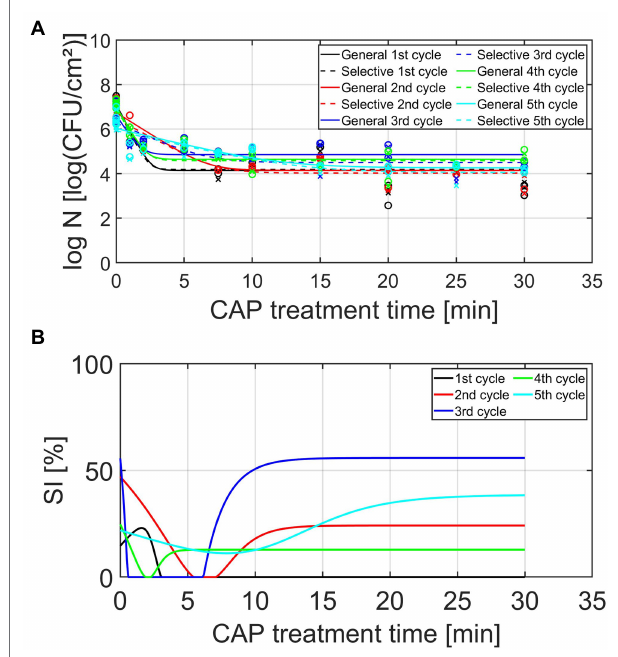
FIGURE 4 | (A) Cell density [log 10 (CFU/cm 2 )] and (B) percentage (%) of sub-lethally injured (SI) cells, both as function of the CAP treatment time for the Listeria monocytogenes model biofilms ( n = 2). Five consecutive CAP treatment cycles were performed as: isolates from cycle × survivors were